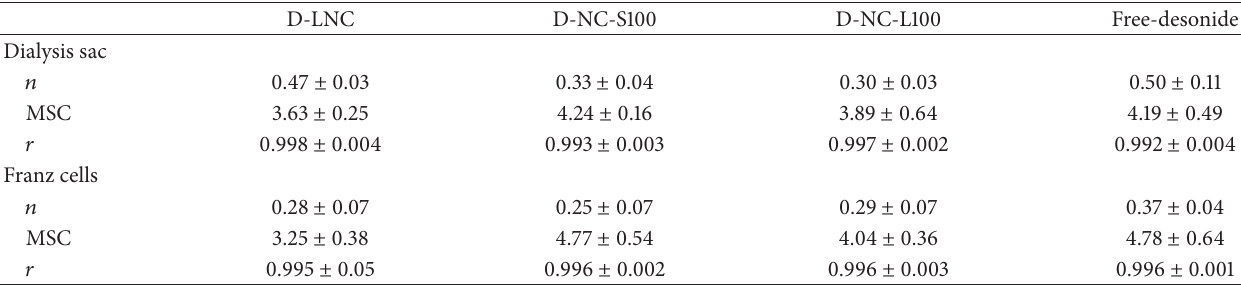
Table 6: Correlation coefficient ( 𝑟 ), model selection criteria (MSC), and release exponent ( 𝑛 ) obtained by fitting the release profiles of desonide according to the Korsmeyer-Peppas